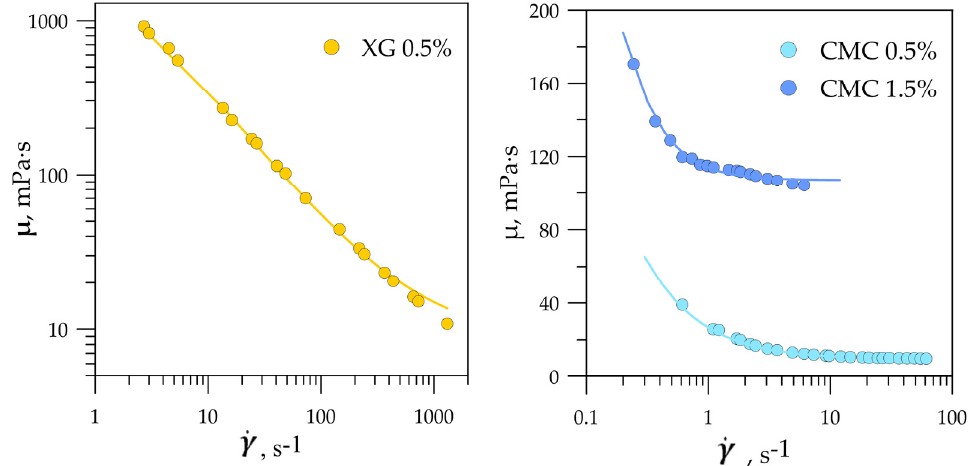
Figure 2. Dynamic viscosity of shear-thinning liquids depending on shear rate.